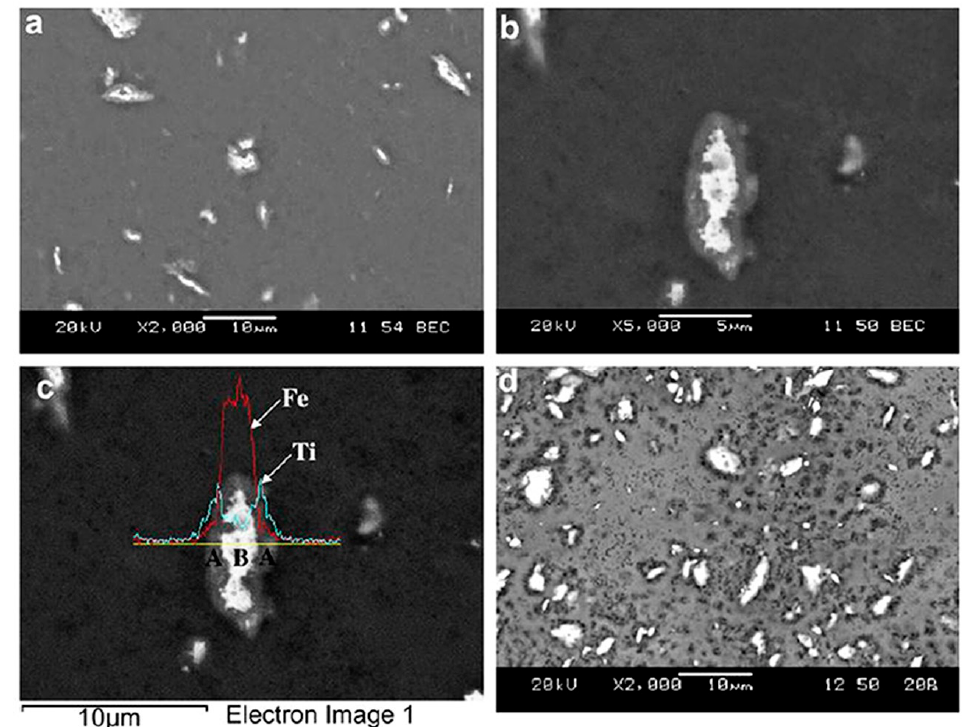
Figure 4. Backscattered SEM images and EDS analysis of HA-Ti-33 wt. % Fe composites sintered in vacuum at 1000 °C; ( a ) image of HA/5% (Ti-33 wt. % Fe); ( b ) high-magnification image; ( c ) EDS line scan across a typical Ti-Fe particle and ( d ) image of HA/15% (Ti-33 wt. % Fe) [63].